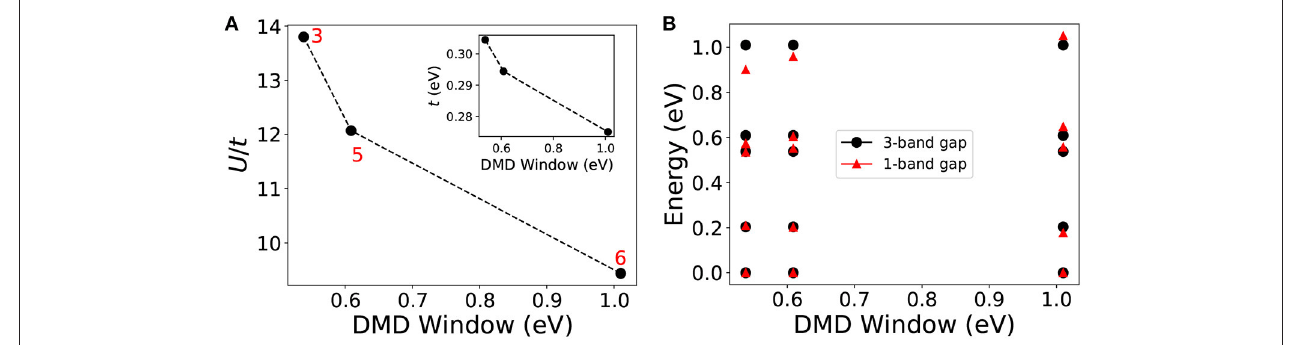
FIGURE 6 | Dependence of the downfolding parameters on the chosen low energy manifold. (A) shows the variation of downfolded parameters U / t and t (inset) with low energy manifolds of different energy windows (corresponding to 3, 5, and 6 low energy eigenstates); (B) shows the energy spectra of the effective one-band model (red triangles) in comparison to the spectra of the original three-band model (black circles). The three-band Hubbard model is on the 2 1/ t pd 3, and t pd 1.3 = =